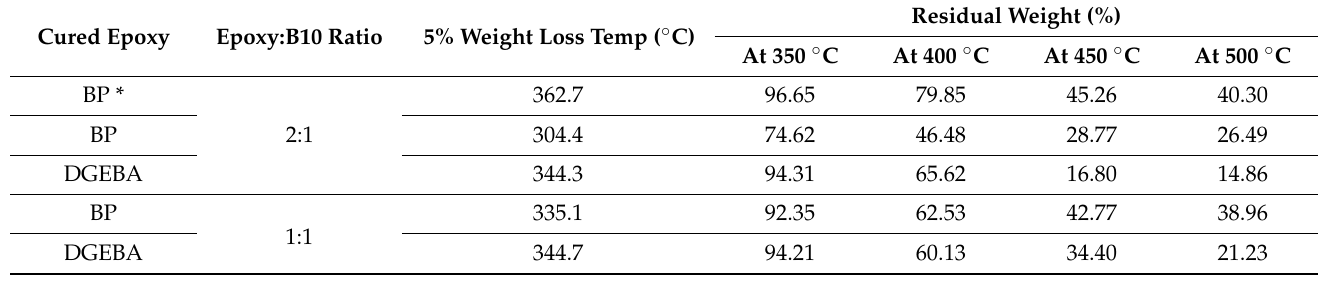
Table 1. 5% weight loss temperature and residual weight of cyanate ester-cured epoxy resin.